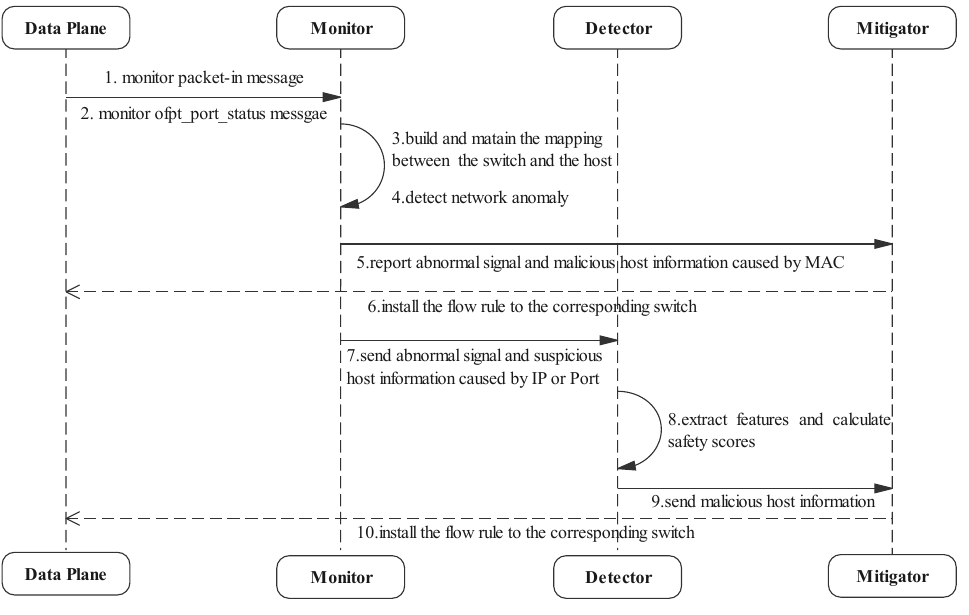
Figure 3. Workflow of